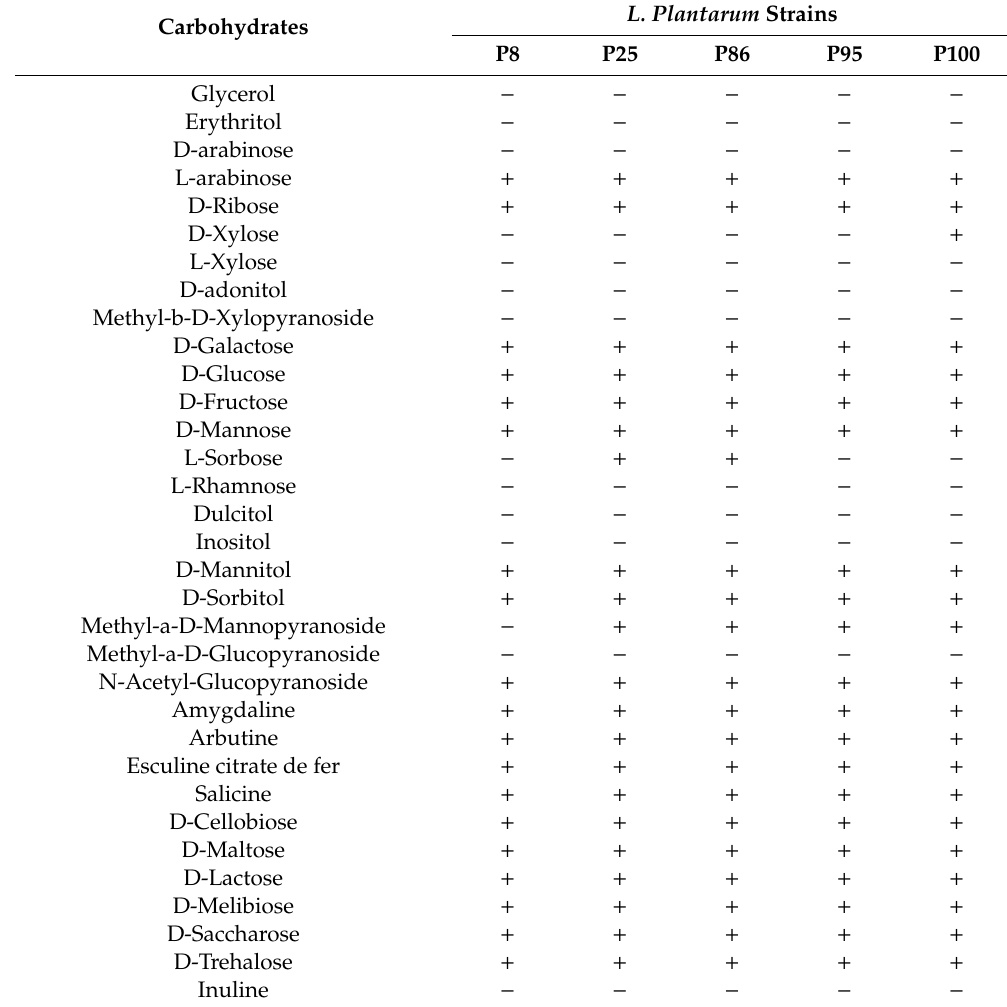
Table 3. Carbohydrate assimilation patterns of the five L. plantarum strains, performed using API 50 CHL system kit. + positive; −